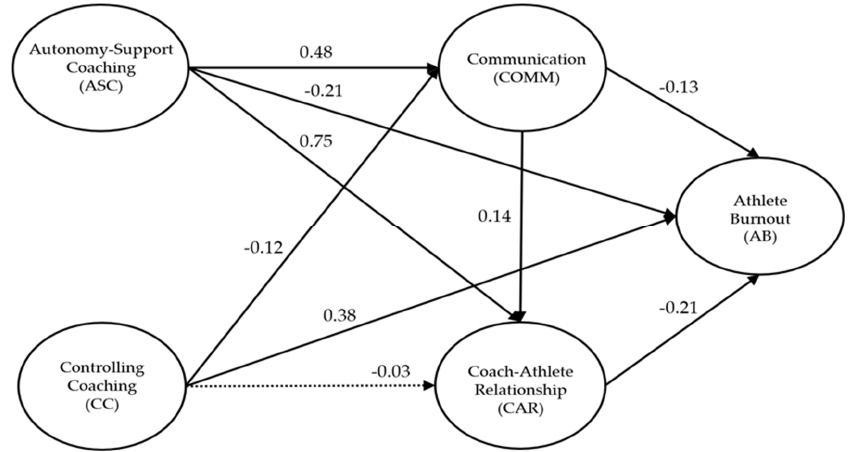
Figure 1. Proposed structural model. Solid lines indicate significant paths at p < 0.05. Dotted lines indicate insignificant paths. Values shown next to the solid lines are standardized regression coefficients. Table 4. Path coefficients between Latent Variables.